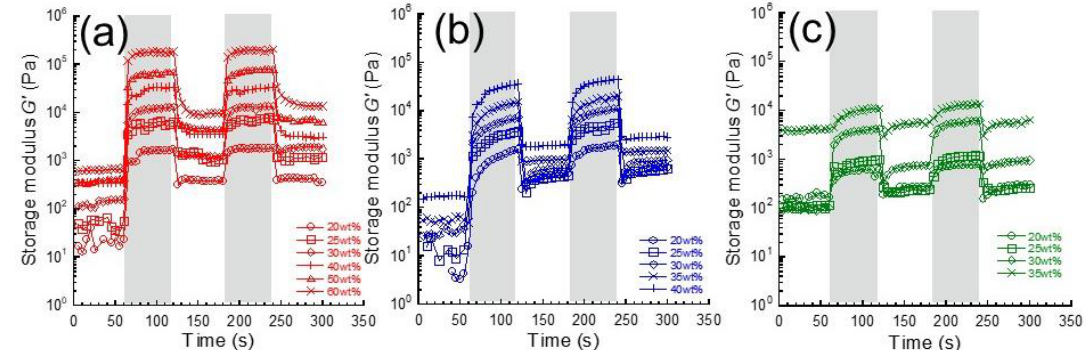
Figure 2. Magnetic response of storage modulus at γ = 10 −4 and 1 Hz for carrageenan magnetic hydrogels with ( a ) carbonyl iron, ( b ) iron oxide, and ( c ) barium ferrite particles with various concentrations of magnetic particles. Magnetic fields were applied in the shadowed area.